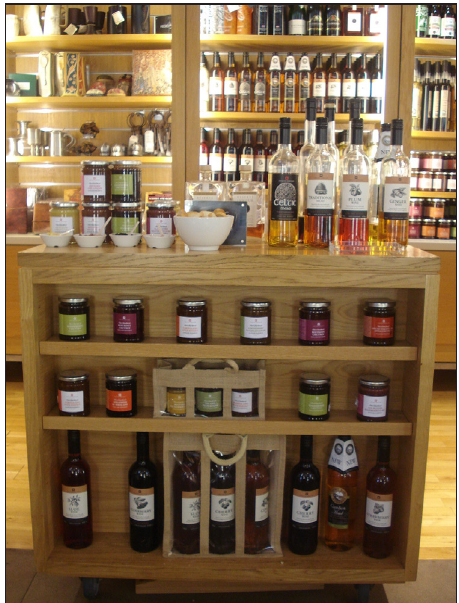
Figure 4: Samples desk at Whitby